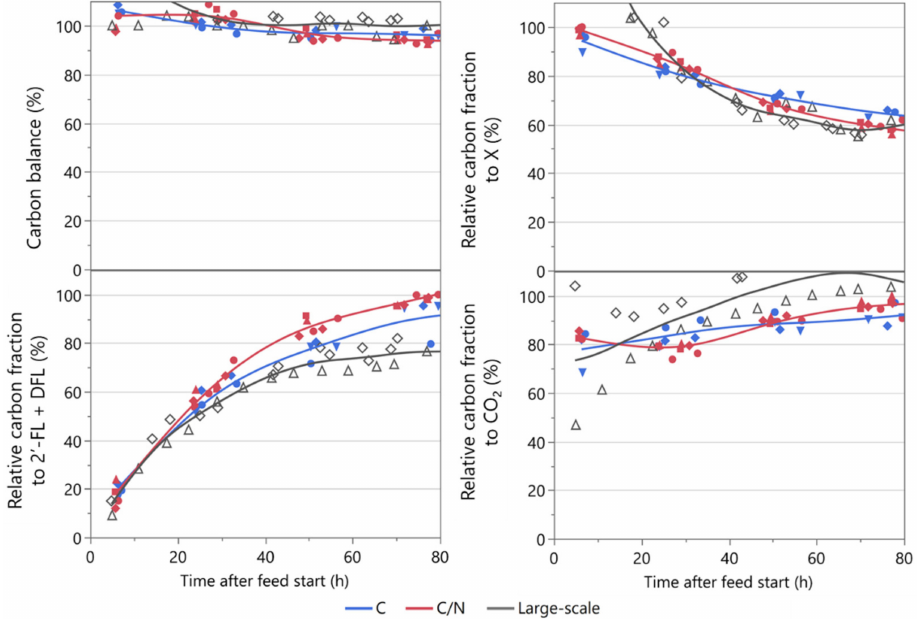
Figure 5. Carbon balance and carbon allocation of laboratory and industrial fermentations. Carbon allocation to the products 2 (cid:48) -FL and DFL as well as biomass (X) and CO 2 were estimated from offline and online measurements. Each curve represents three independent experiments from laboratory- scale and two from large-scale processes. The values were relativized by normalizing to the end-point value of the average of the three fermentations without CO 2 enrichment under C/N limitation.